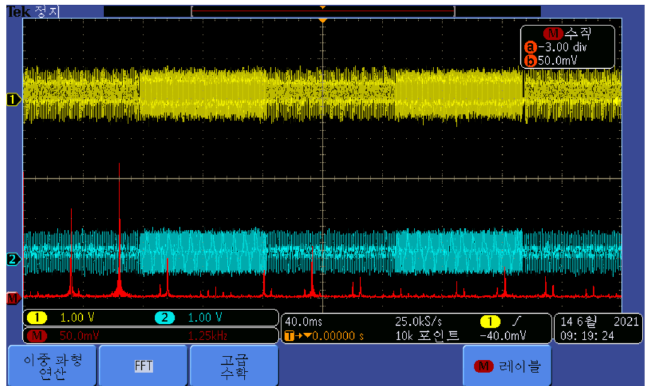
Figure 31. Transmitter and receiver frequency characteristics (low side).